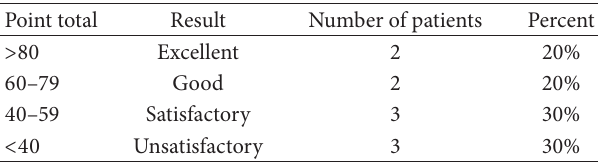
Table 4: The analysis of the Ankle Scores (AS) from the group of patients that underwent the original Pirogow’s